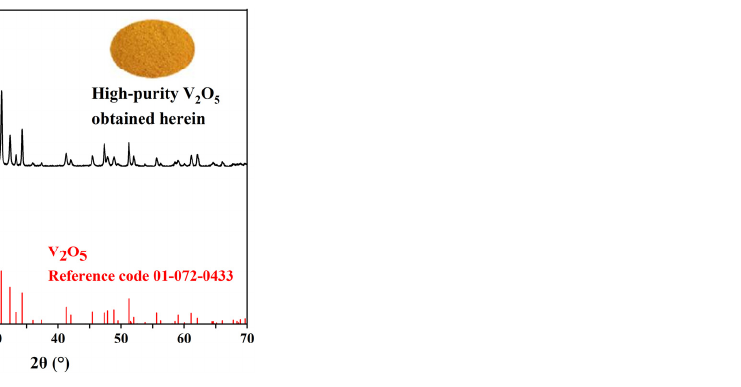
Figure 13. XRD pa tt ern and image (inset) of V 2 O 5 obtained herein. The XRD pa tt ern of our V 2 O 5 matched well with that of the V 2 O 5 standard (standard card code 01-072-0433) and did not contain any impurity peaks.